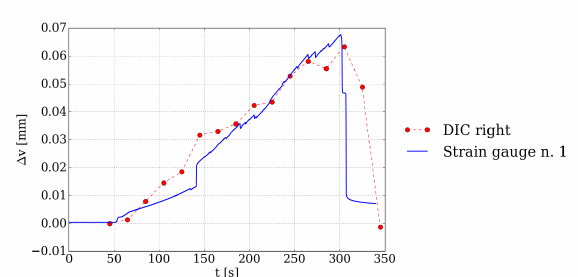
Figure 10: Comparison between the vertical displacements ob- tained by the DIC method and the strain gauges measurements for sample n. 1.